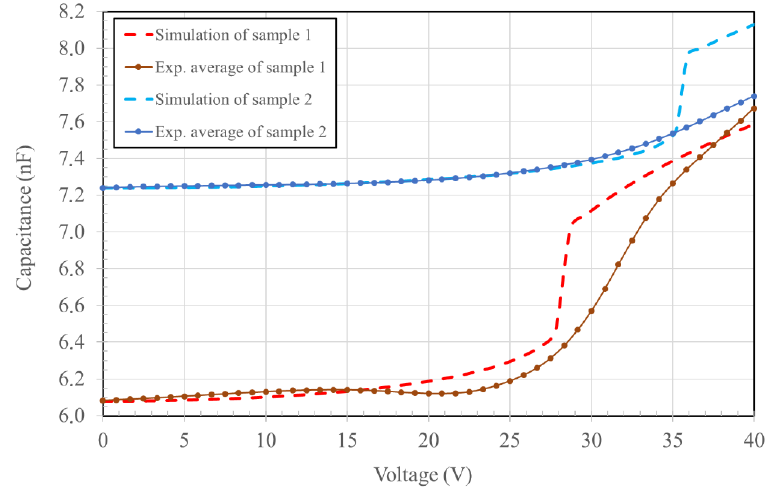
Figure 9. Capacitance versus applied voltage of the simulations and experimental results for the sample 1 and 2 devices.